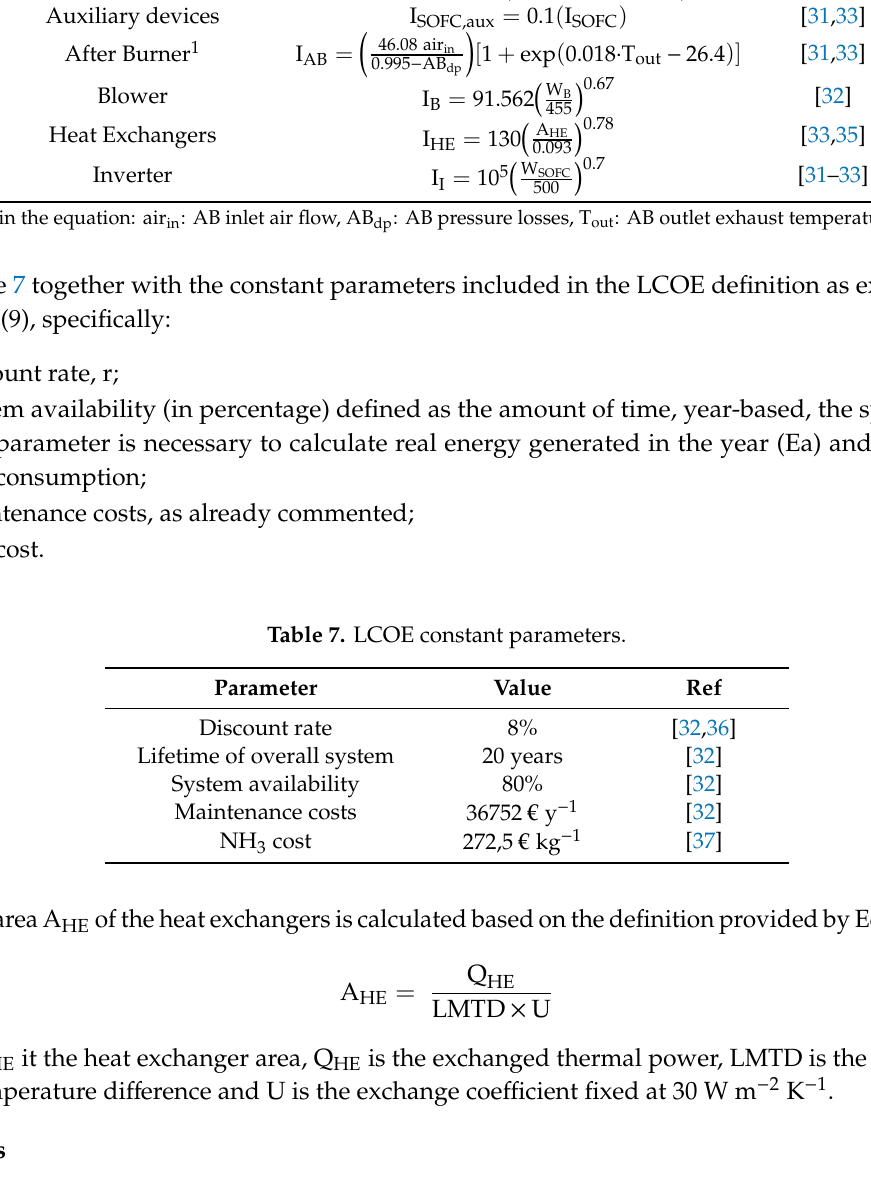
Table 6. Capital cost function of system components.